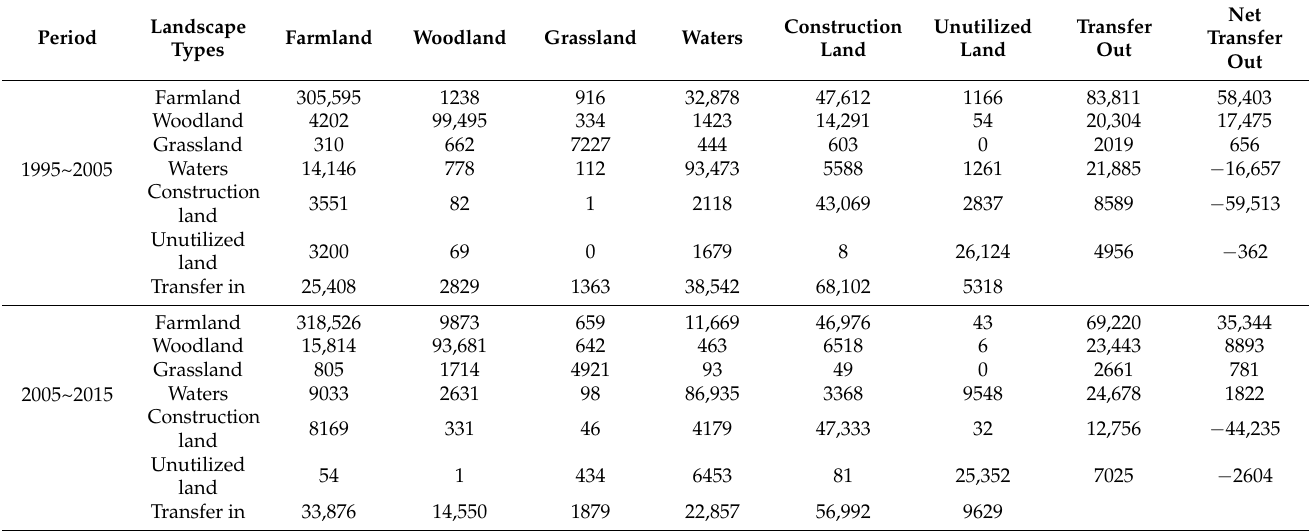
Table 3. Land use transfer matrix in the study area (ha).